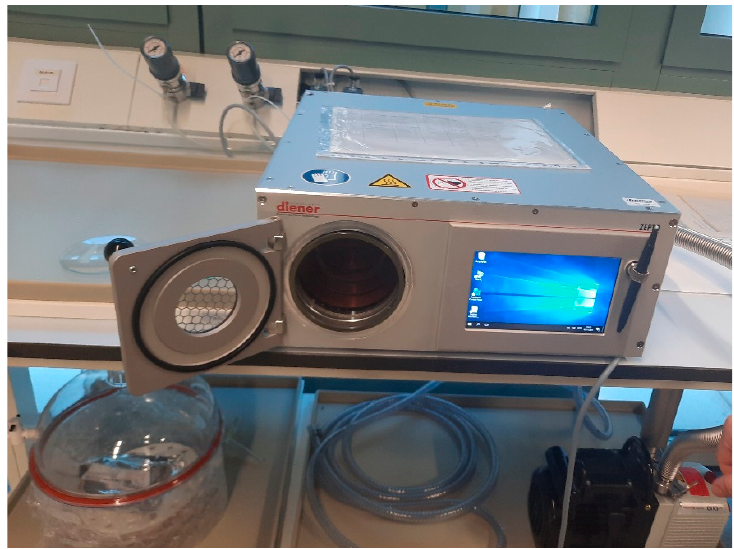
Figure 5. Low-pressure plasma apparatus used with argon and with polymerization treatment. Table 1. Peak powers and times used in the PEG polymerization plasma treatments.